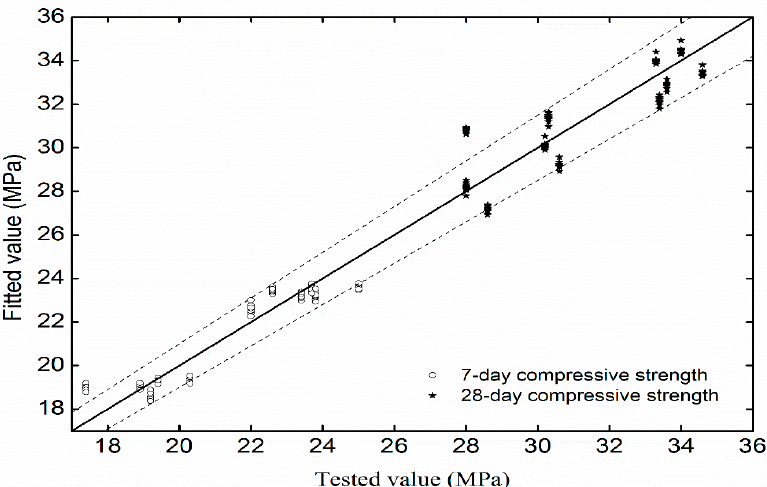
Figure 3. Relationship between tested compressive strength and fitted compressive strength of concrete.